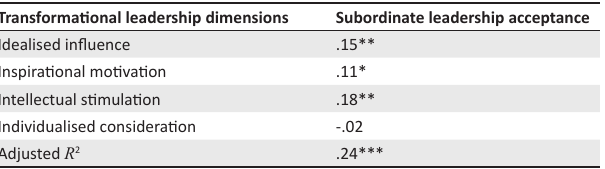
TABLE 2: Linear regression analysis estimates for transformational leadership dimensions and subordinate leadership acceptance.